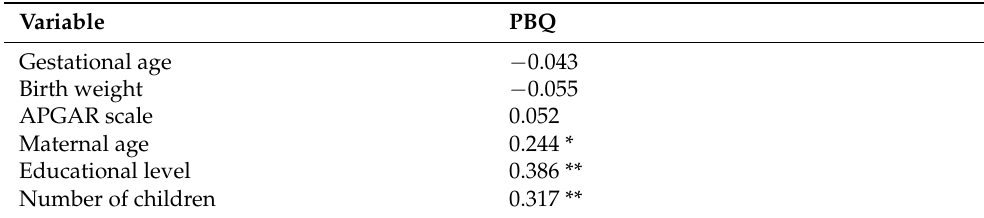
Table 5. Spearman correlation results of Maternal-Infant bonding with socio-demographic variables and child’s